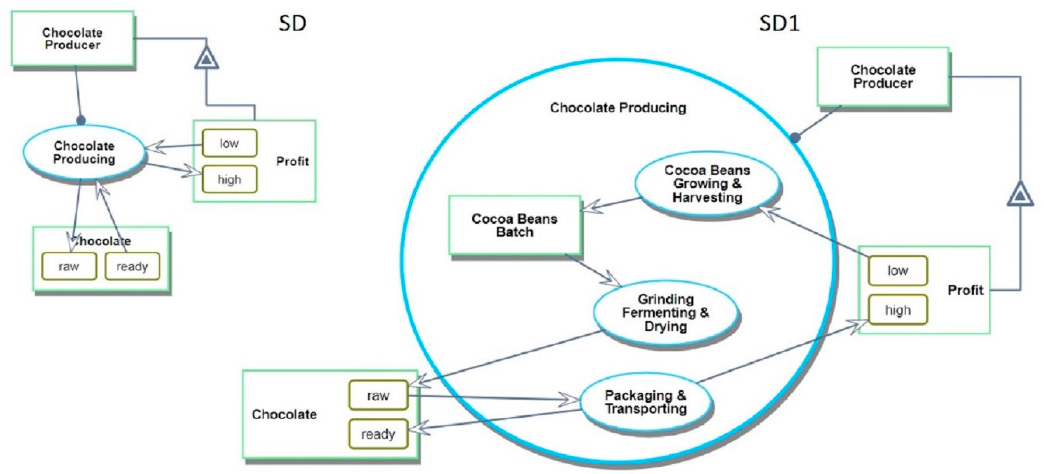
Figure 2. Chocolate production model. SD (left) and SD1 (right).